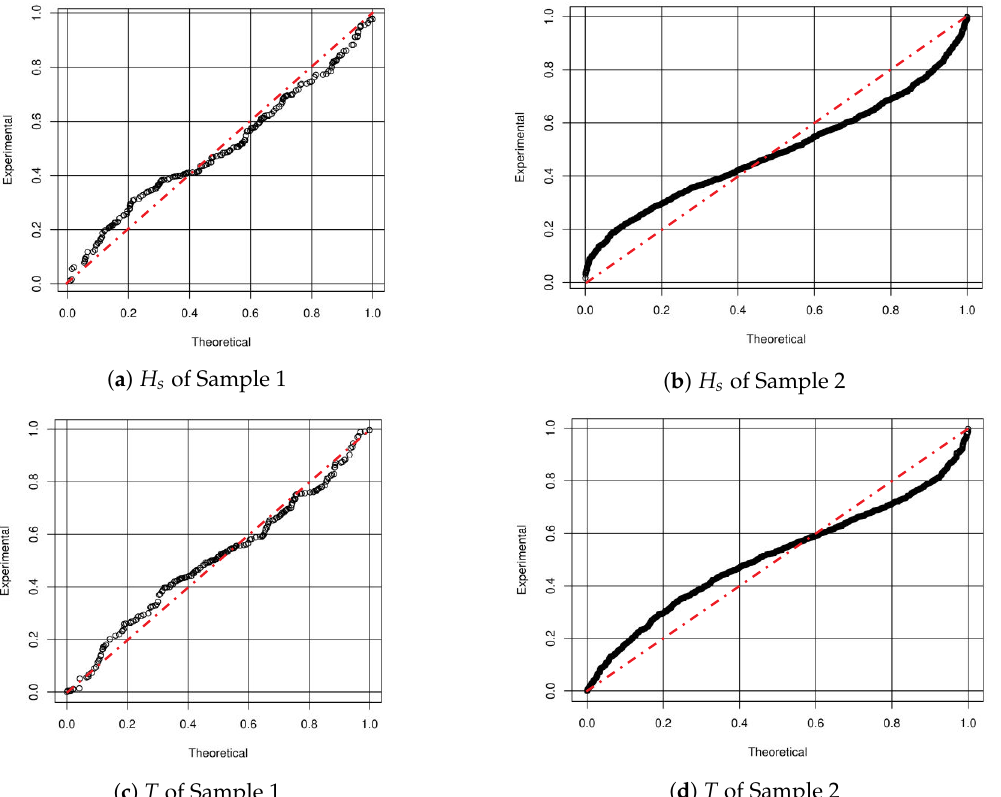
Figure 2. Quantile-Quantile plots of uniform residuals of H s and T models. The dashed red line shows the identity